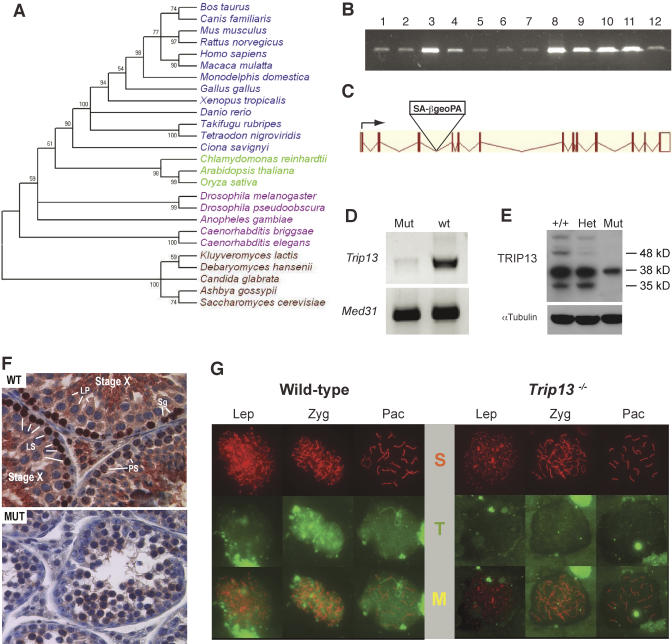
The Mouse PCH2 Ortholog TRIP13 and Expression in Wild Type and Mutant(A) Phylogenetic tree of presumed PCH2/TRIP13 orthologs. The database sequence accession number of each protein is presented in Table S1. Numbers shown are bootstrap values (see Materials and Methods). The clustering was the same regardless of whether the whole entire AA sequence or trimmed sequences (where regions showing little conservation were removed) were used for the analysis. Major eukaryotic groups are indicated in color, with deuterostomia in blue, plants in green, protostomia in purple, and fungi in maroon.(B) Amplification products of cDNA from the following tissues: 1, heart; 2, brain; 3, spleen; 4, lung; 5, liver; 6, skeletal muscle; 7, kidney; 8, testis; 9, E7 embryo; 10, E11 embryo; 11, E15 embryo; and 12, E17 embryo.(C) Intron–exon structure of TRIP13 and insertion site of gene-trap vector. See Materials and Methods for details on how the precise insertion site was identified.(D) RT-PCR of Trip13 and a control gene Med31 from testis RNA. The Trip13 primers are situated in the first and last exons (see Materials and Methods).(E) Western blot analysis of testis protein with anti-TRIP13 antibody. The blot was later probed with anti-alpha tubulin actin as a loading control. The expected TRIP13 protein is ∼48 KDa.(F) Localization of TRIP13 in testes. Wild-type (top) and mutant (bottom) testis sections were probed with chicken anti-TRIP13, and detected with HRP-conjugated anti-chicken IgG (brown/red staining). Expression in WT was most prominent in the nuclei of Type B spermatogonia (Sg), leptotene spermatocytes (LS), and early pachytene spermatocytes (PS), but not late pachytene spermatocytes (LP). No nuclear staining was seen in mutant testis sections, although reddish cytoplasmic background is present. Identification of cell types was judged in part by estimating the epithelial stage of the tubules as described [67].(G) TRIP13 localization in surface-spread spermatocytes. Preparations were immunolabeled with anti-SYCP3 (S) and TRIP13 (T). Both individual and merged images are shown for leptotene (Lep), zygotene (Zyg), and pachytene (Pac) spermatocytes. Nuclear staining was absent in the mutant.